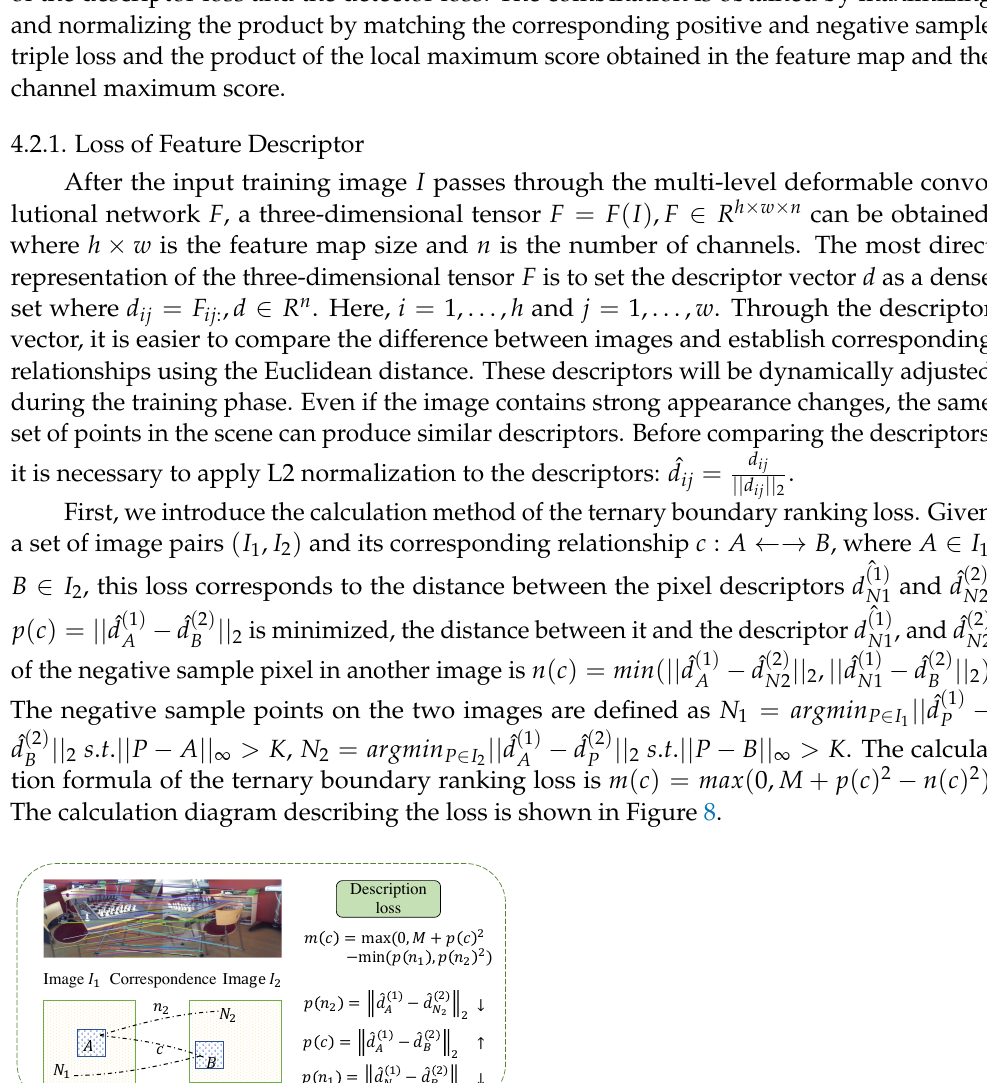
Figure2 processFigure1 Sequential